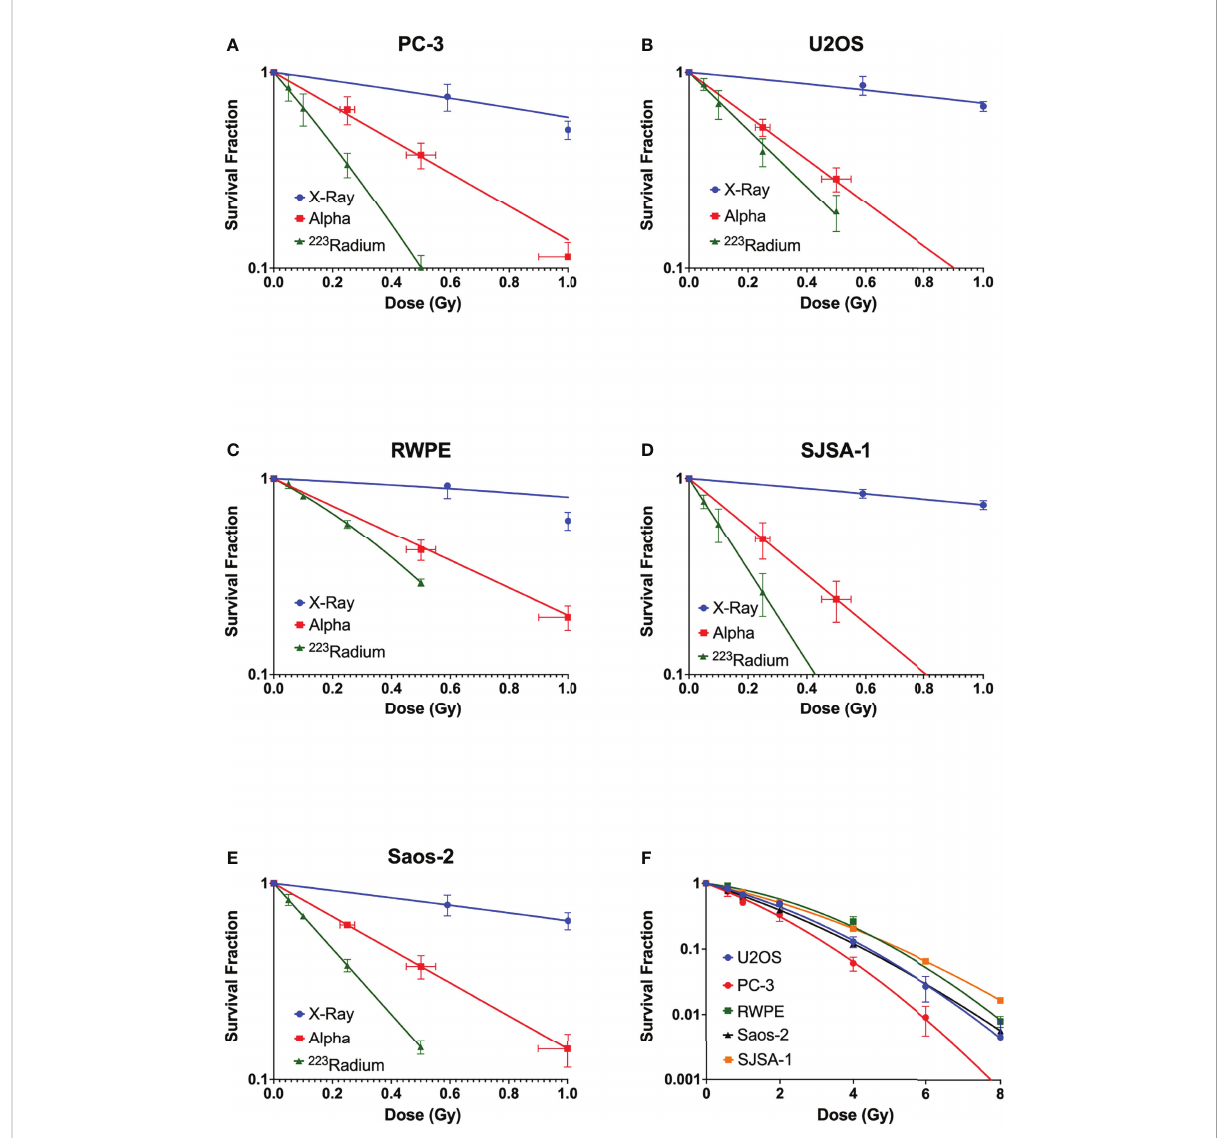
FIGURE 1 Survival curves of (A) PC-3, (B) U2OS, (C) RWPE, (D) SJSA-1, and (E) Saos-2 cells obtained after exposure at different doses of X-rays (blue) and external alpha source (red) or exposure to 223 Ra for 24 h (green). (F) Comparison of X-ray survival curves for different cell lines. Data were fi t to the linear quadratic model. Points represent the mean of at least three independent experiments with respective standard